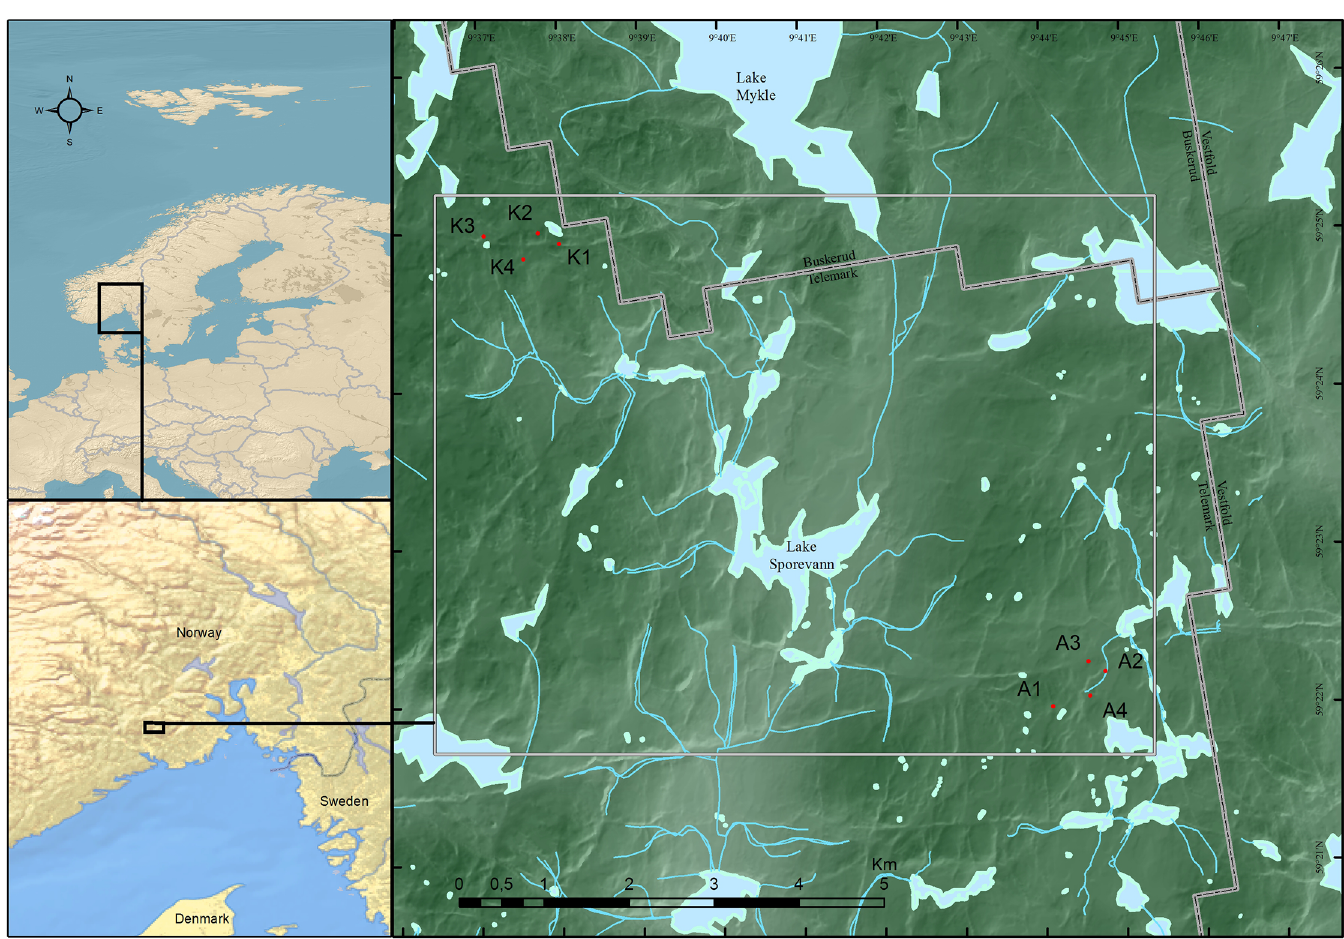
Fig 1. Map of study area. Location of the study plots in a boreal forest landscape in SE Norway. Plots labeled with K are located close to the small lake Kapteinstjern, and plots labeled with A are located SW of the lake Å rumsvannet. Reprinted from Kartverket under a CC BY license, with permission from Kartverket, original copyright Kartverket 2013.